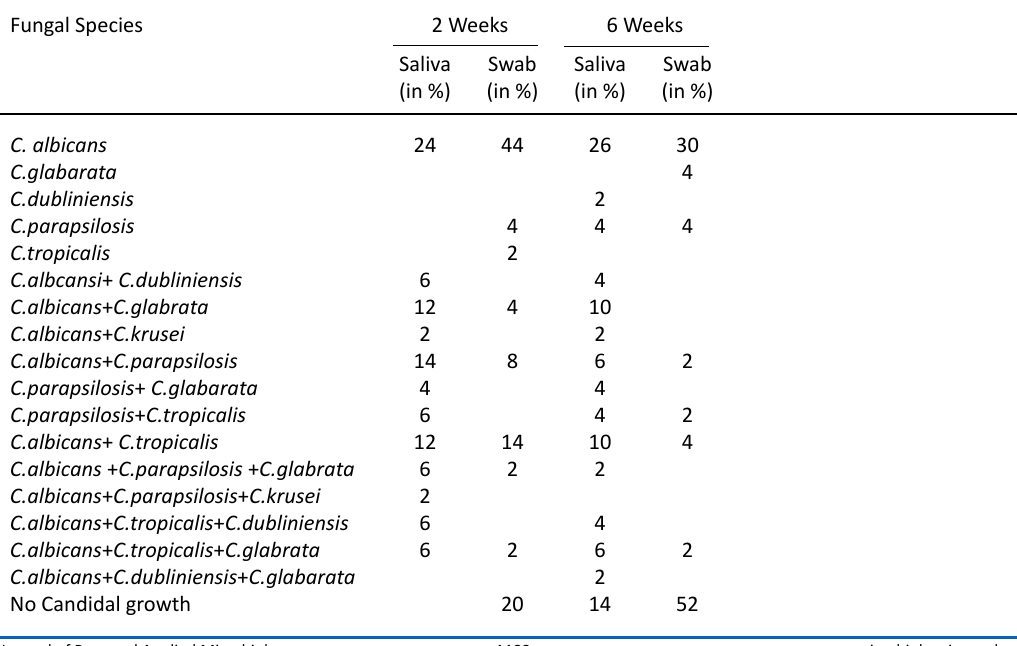
Table 2. Percentages of salivary and swab samples of oral cancer patients showing growth of fungal species after two- and six-weeks of radiotherapy Fungal Species 2 Weeks 6 Weeks Saliva Swab Saliva Swab (in %) (in %) (in %) (in